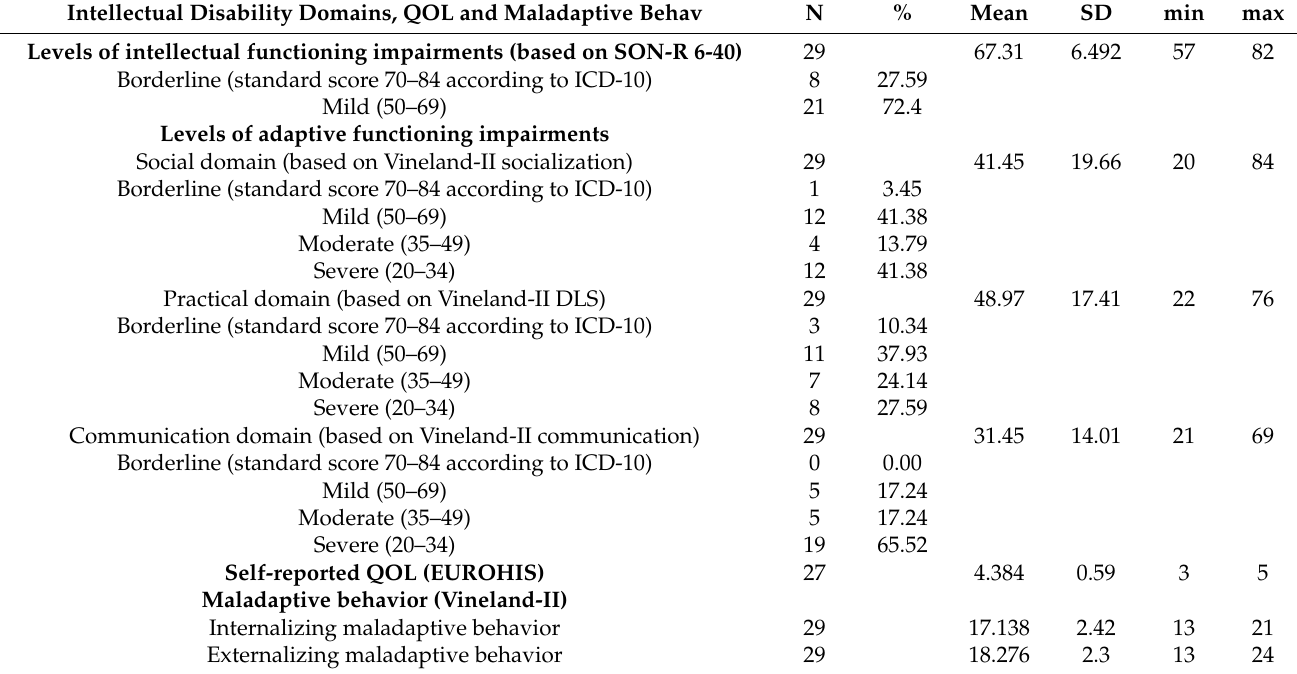
Table 2. Descriptive results for intellectual disability domains, QOL and maladaptive